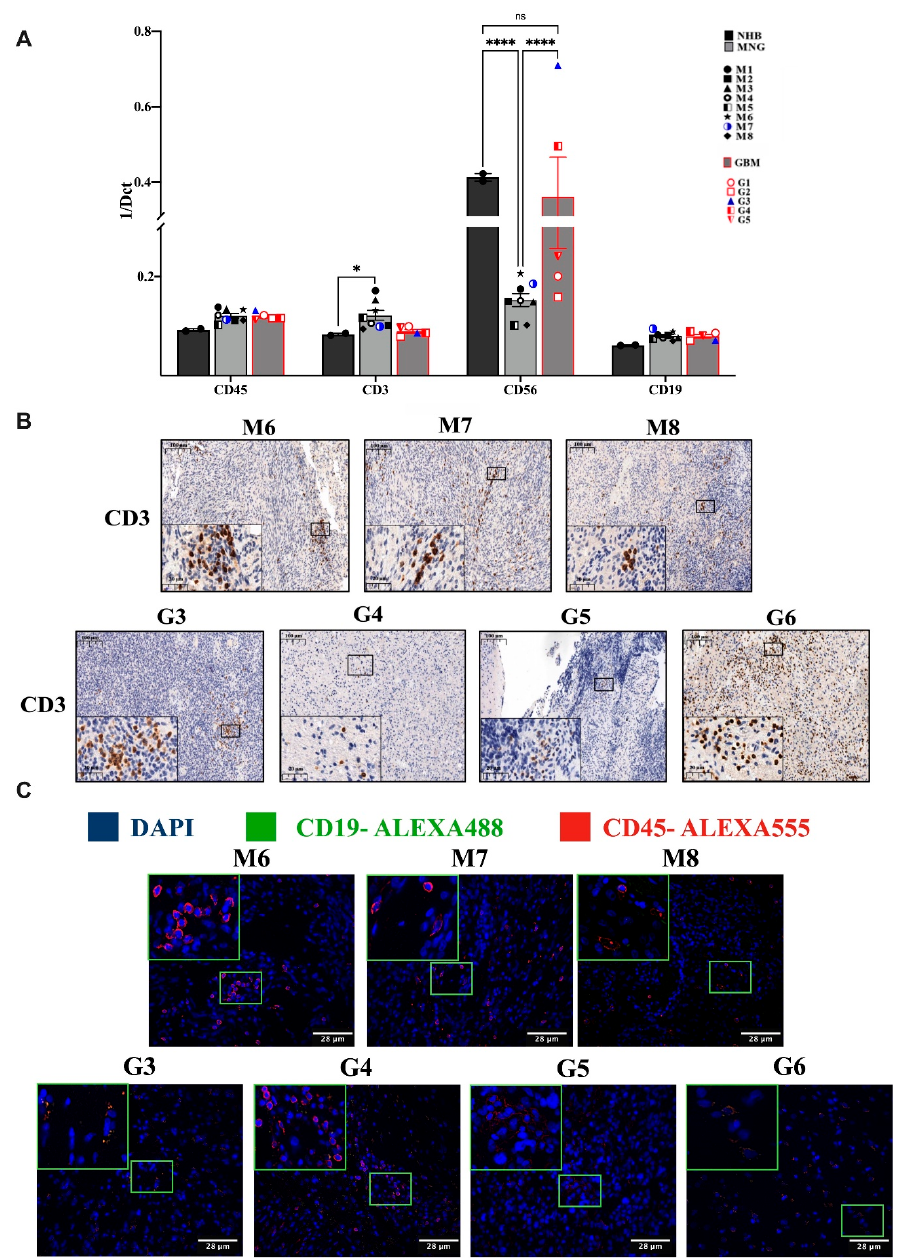
Figure 1. Infiltration of immune cell populations into MNG and GBM. ( A ) mRNA levels of the general leukocyte antigen CD45 and general immune cell subpopulation CD3 + T, CD56 + NK and CD19 + B cell markers in MNG ( n = 8) and GBM ( n = 5). Data are presented as 1/dCt individually and as average ± SEM. Significant changes are marked as * and **** ( p < 0.05 and p < 0.0001, respectively). ( B ) Immunohistochemistry staining of CD3 T-cell population in both brain tumor types (GBM and MNG), magnification × 20 and × 40, size bar 100 and 20 µ m respectively. ( C ) Immunofluorescence staining of the general leucocytes marker CD45 and of CD19 in MNG ( n = 3) and GBM ( n = 4), mag- nification × 40, size bar 28 µ m. Only red staining can be detected in MNG and yellow (overlapping red and green) in some GBM